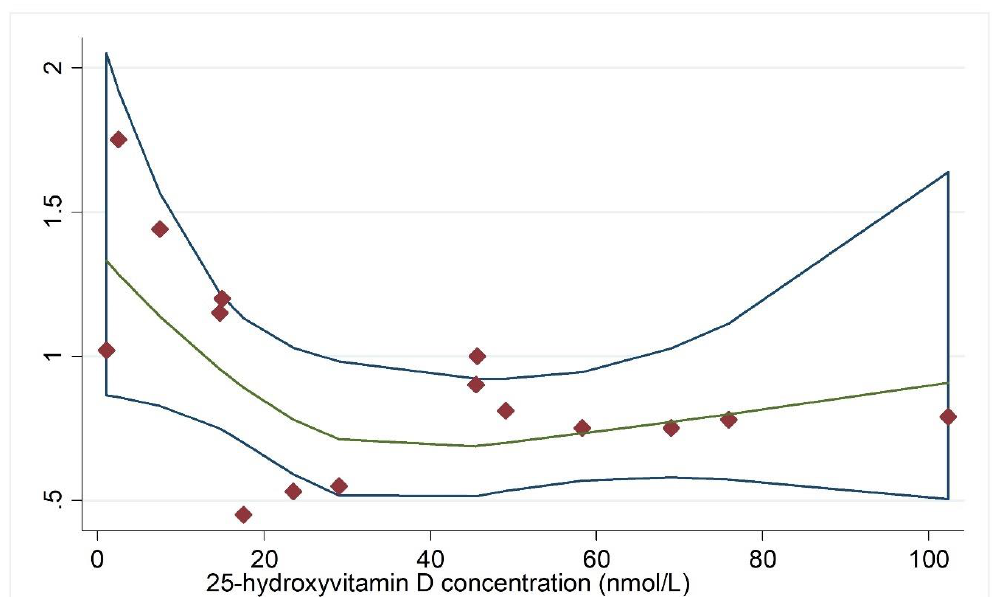
Figure 4. Dose-response analysis for vitamin D concentration and cancer incidence. Adjusted RRs from each exposure quantile of 25(OH)D concentration in included individual studies were represented by the diamonds, and corresponding intervals (CIs) were represented by the blue trendline. Abbreviations: RR, relative risk. The green line indicated the dose-response linear trend between 25(OH)D concentration and risk of cancer incidence by use of variance-weighted least squares regression of fixed e ff ect